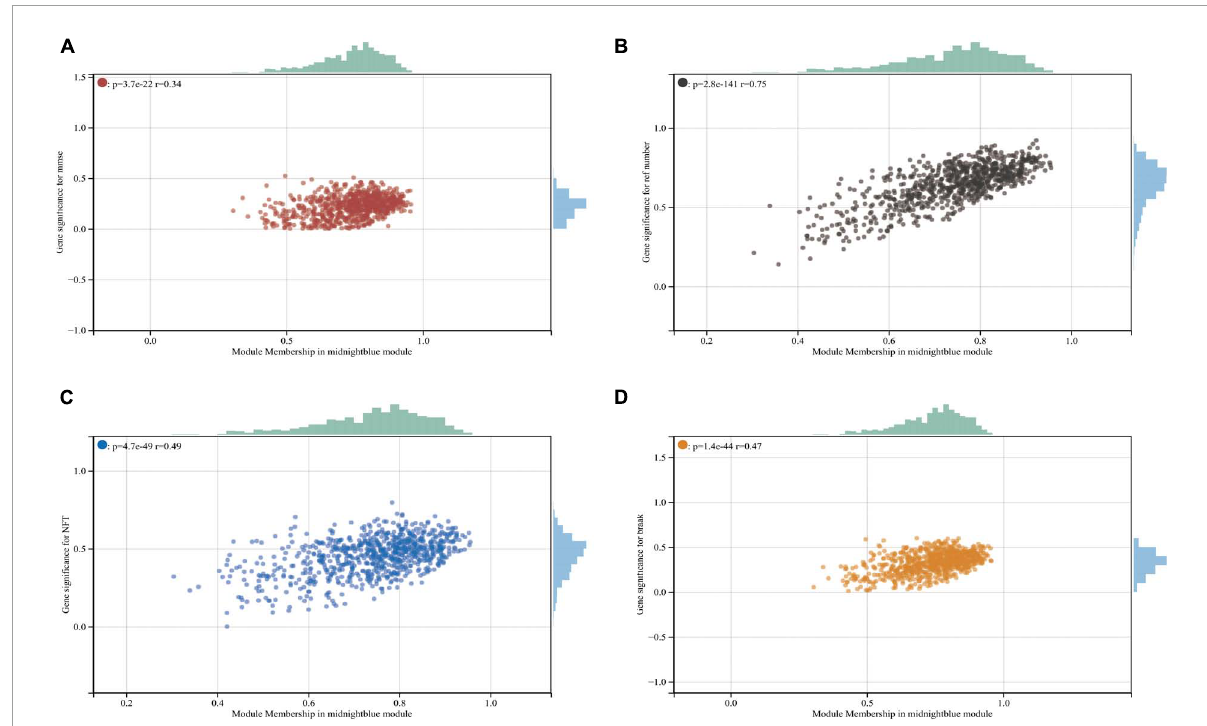
FIGURE2 Midnightblue module and clinical relevance. (A) Scatter plot between module membership in midnightblue module and the clinical information MMSE. (B) Scatter plot between module membership in midnightblue module and clinical information ref number. (C,D) Scatter plot between module membership in midnightblue module and clinical information NFT and break, respectively.